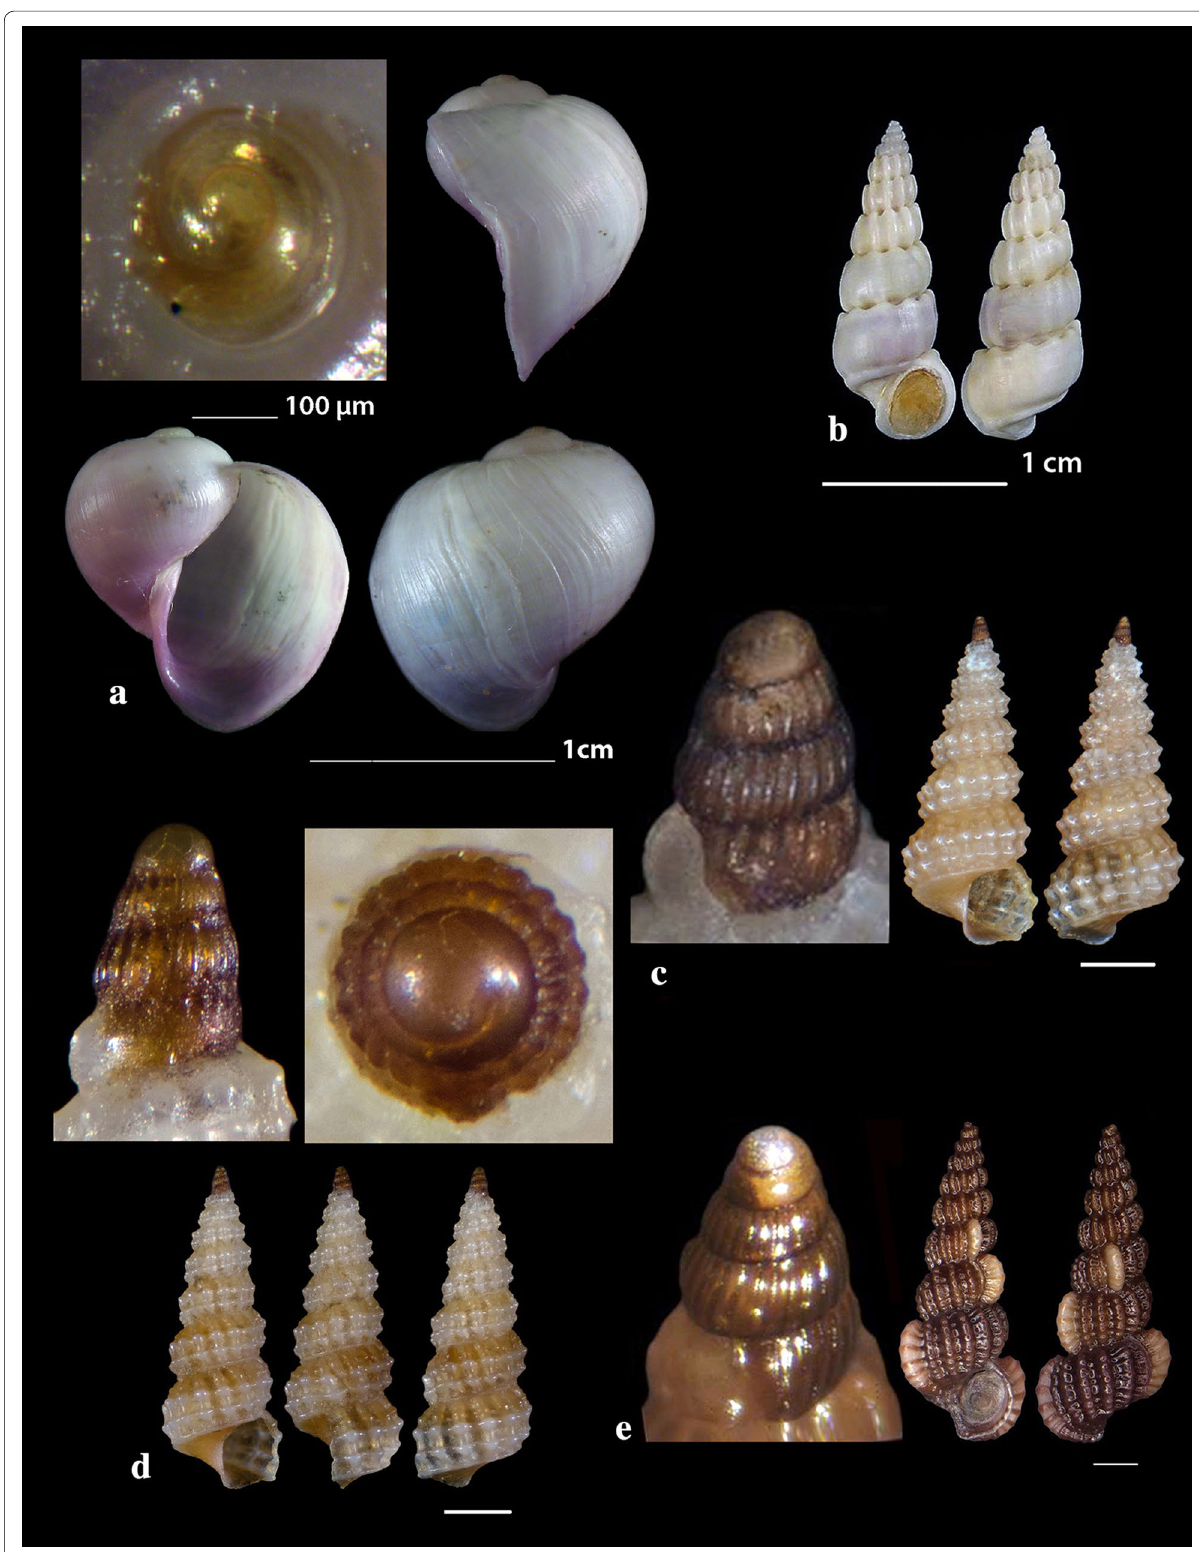
Fig. 17 a Janthina pallida , b Opalia crenata , c , d Narrimania concinna , e Opaliopsis atlantis. Bar